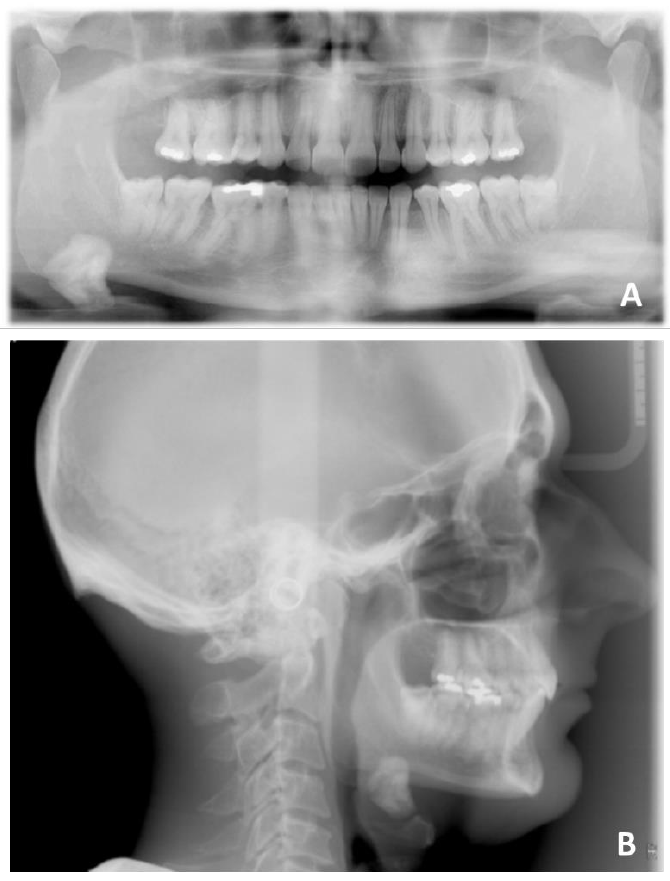
Figure 12. Post-treatment extraoral and intraoral photos of case number 1: frontal facial view ( A ); frontal facial view smiling ( B ); right facial view ( C ); right facial view smiling ( D ); right arches view ( E ); frontal arches view ( F ); left arches view ( G ); upper arch occlusal view ( H ); lower arch occlusal view ( I ).